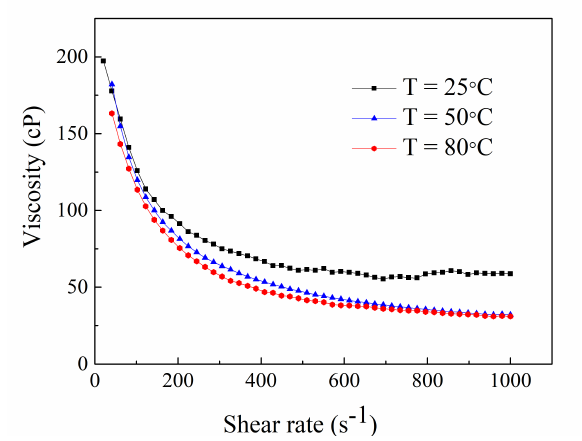
Fig. 4. Shear viscosity of HPAM at different temperature. Fig. 5. Shear viscosity of HPAM and HPAM-SiO 2 NPs at temperature